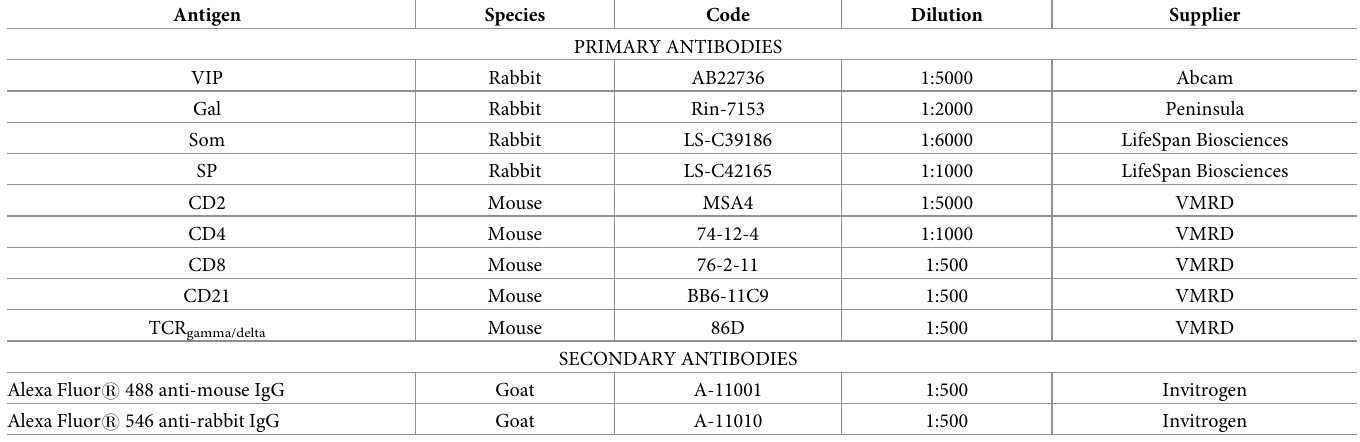
Table 5. Data of primary and secondary antisera used for immunofluorescence stainings. Antigen Species Code Dilution Supplier PRIMARY ANTIBODIES Rabbit Rabbit Rin-7153 1:2000